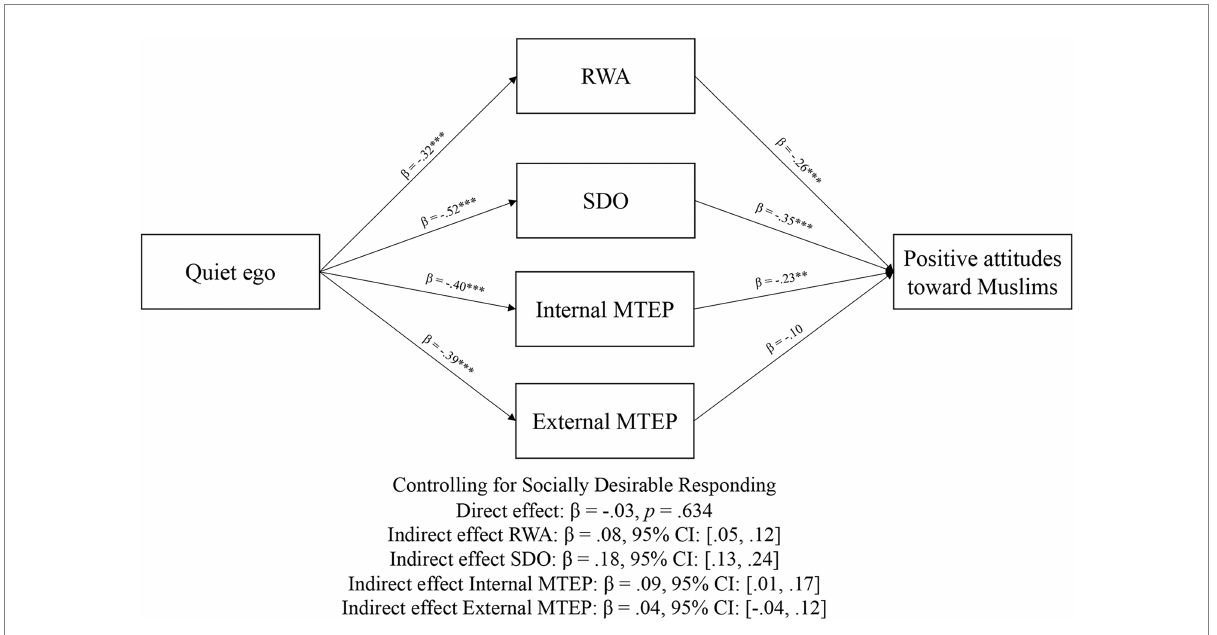
FIGURE 4 Mediation results from Study 2, controlling for socially desirable responding. ** p < 0.01; and *** p <